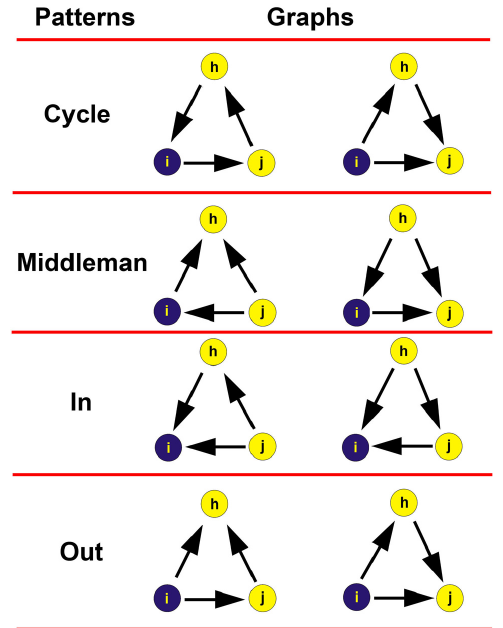
Fig. 5. Possible patterns and graphs, adapted from Fagiolo (1997). The “cycle” configurations do not contribute to the clustering coef-